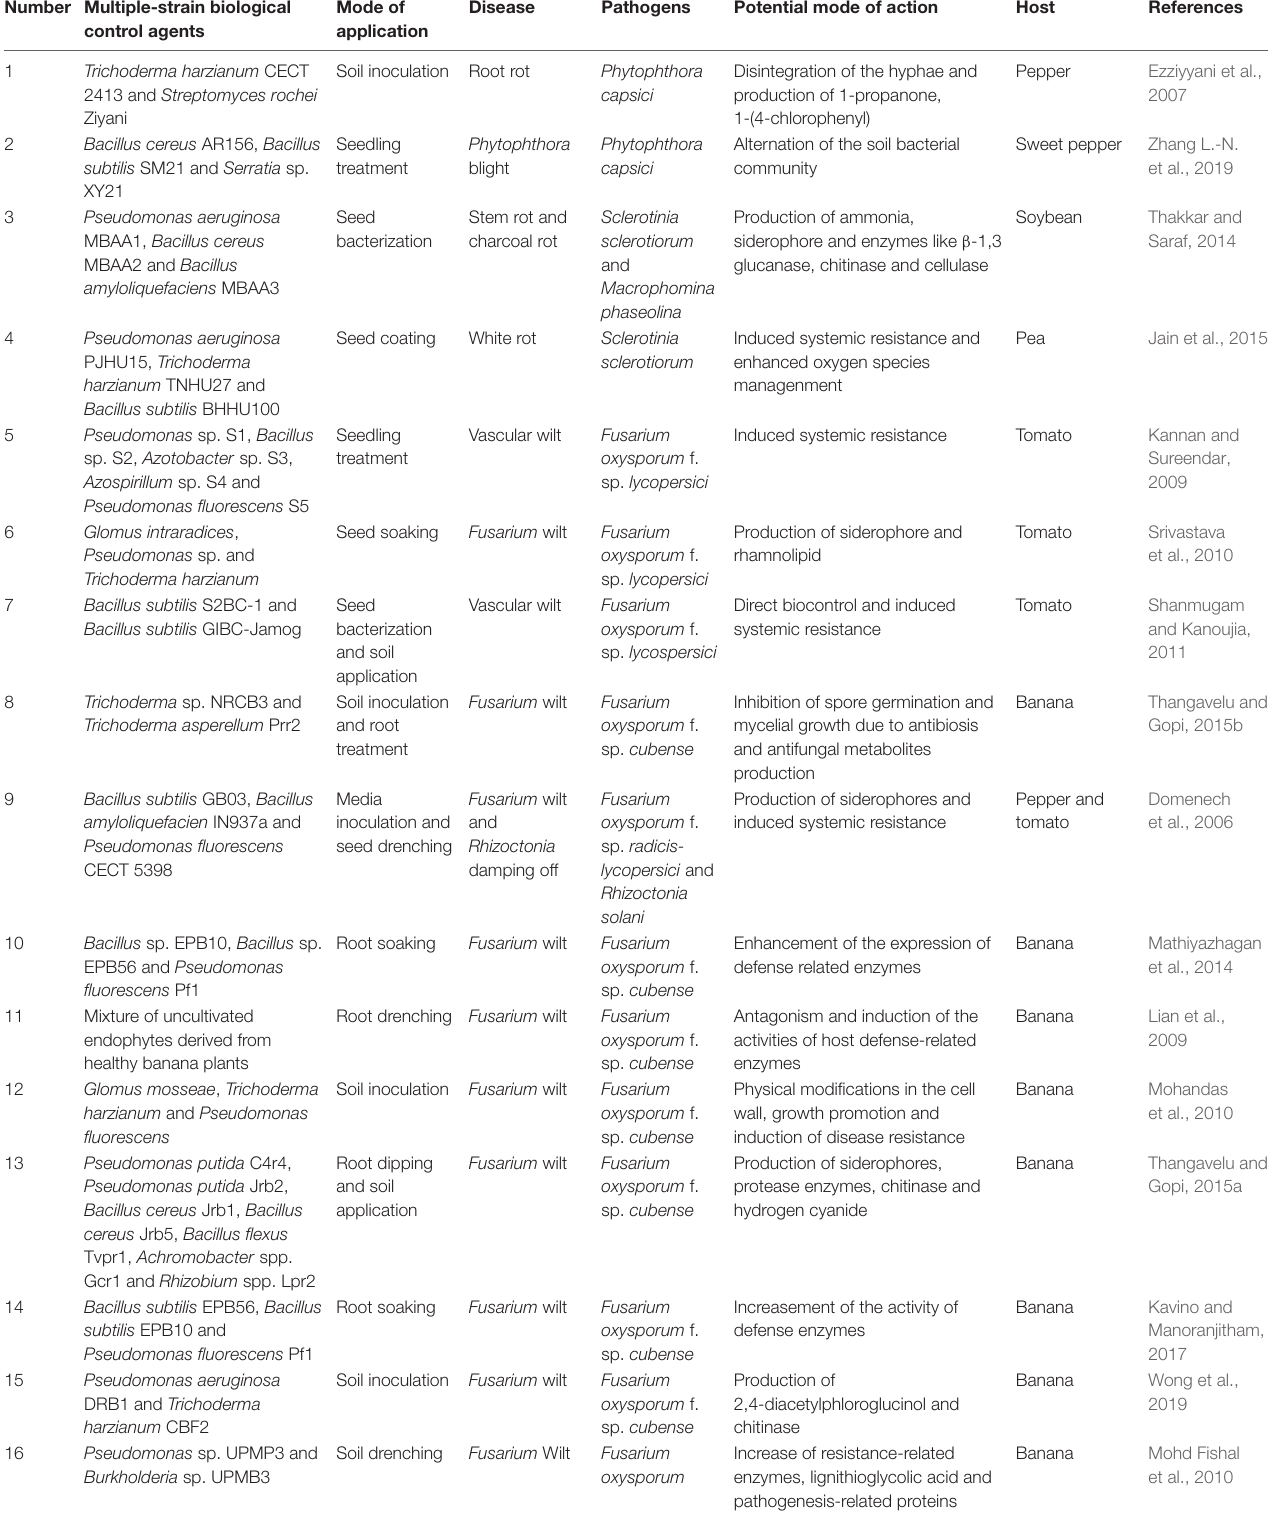
TABLE 1 | List of multiple-strain biological control agents (MSBCAs) against soil-borne